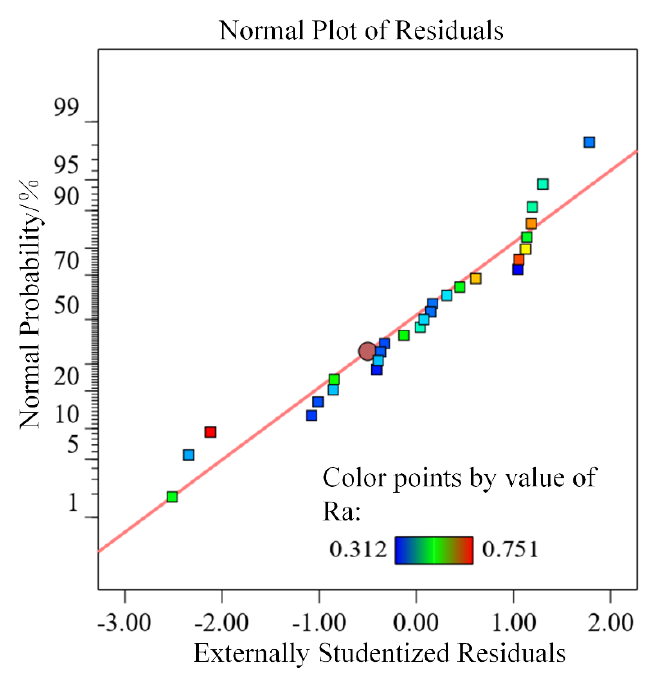
Figure 4. Residual normal distribution.